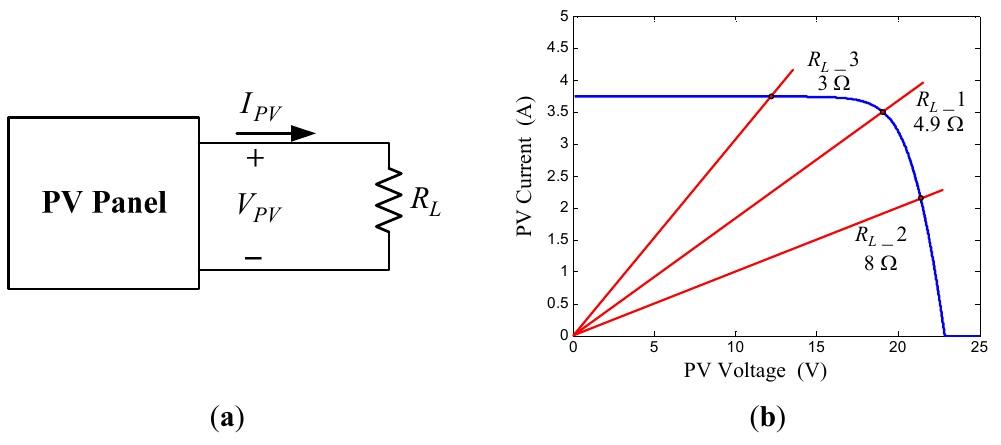
Figure 2. ( a ) PV system with resistive load; ( b ) I-V